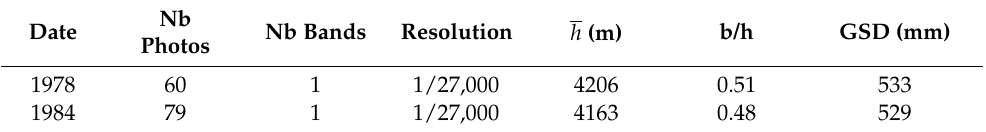
Table 1. Characteristics of the 1978 and 1984 archive photographs used in this study. All photos were taken with an unknown camera equipped with an UAgI 153.23 mm lens (serial number 6023 and 6044, respectively). h is the distance to the ground from the center of the camera; b/h is the average overlapping of the camera and the ground sampling distance (GSD) (0.02 h /f